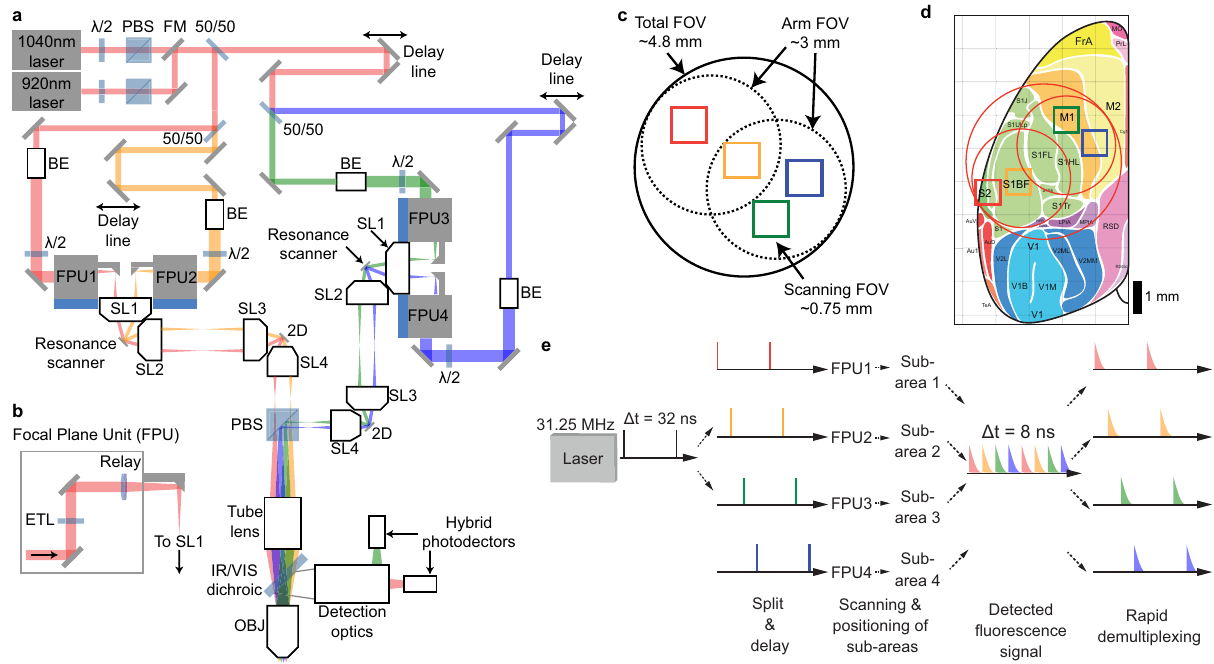
Fig. 1 Large fi eld of view quad area two-photon microscope system. a Schematic of the Quadroscope system. Laser source is selected by a fl ip mounted mirror (FM). Laser output is then split into four beam paths (beam 1 — red, 2 — orange, 3 — green, 4 — blue) using 50/50 beam splitters (50/50). Each beam is delayed 8 ns relative to the other. Each beam is magni fi ed by a beam expander (BE) entering into the focal plane units (FPUs). Half-wave plates ( λ /2) are used in conjunction with a polarizing beam splitter (PBS) to control power of each beam. Two scan engines each control two of the imaging regions. Each scan engine consists of three commercial scan lenses (SL1-3), a resonance scanner, a 2D scanning mirror, and a custom scan lens (SL4) before being combined using the PBS onto a custom tube lens. The beams enter a custom objective (OBJ) before arriving at the sample. A long-pass dichroic (IR/VIS Dichroic) is used to separate the excitation and emission light. b FPU design. Each FPU is mounted on a motorized XY stage and contains an electrically tunable lens (ETL) and relay lens. c Schematic of scan area positioning. Scanning regions of up to ~0.75 mm 2 can be achieved for each of the four sub- areas. Each scan arm has a 3 mm arm fi eld of view (FOV) in which sub-areas can be repositioned using the FPU. The arm FOV can be positioned